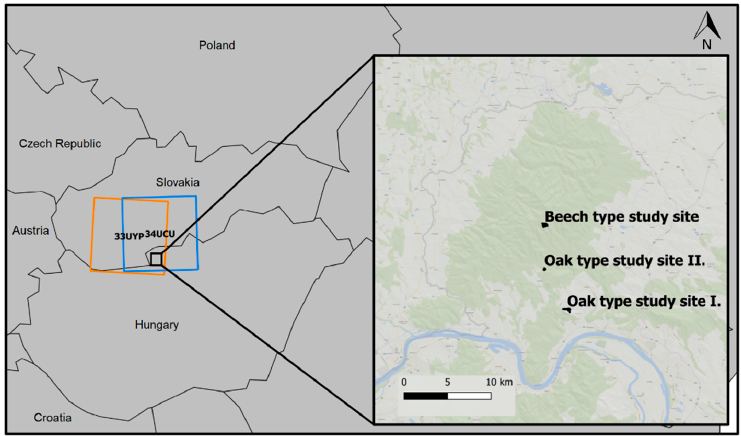
Figure 1. Location of forest study sites in Hungary with Sentinel-2 footprints.